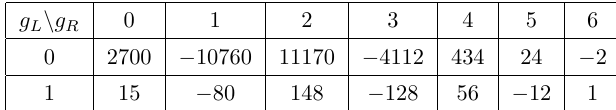
for the homology class β = ( d β